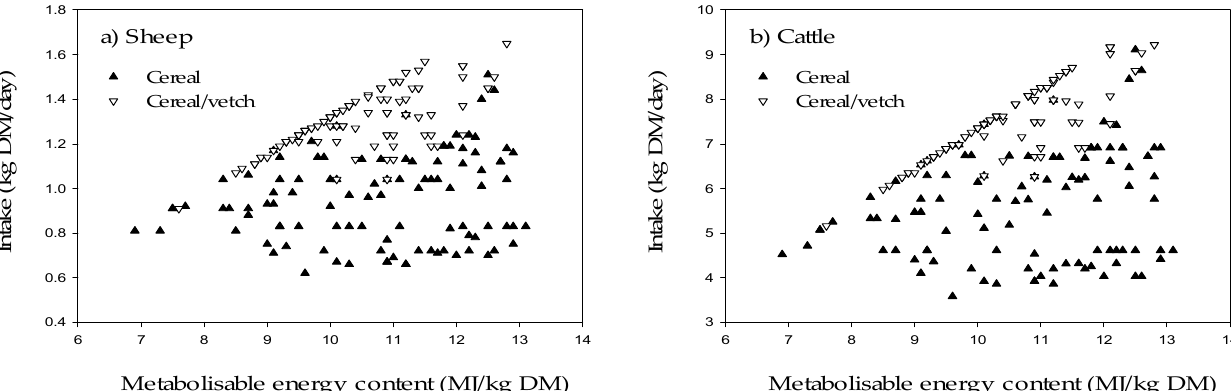
Figure 1. Relationship between estimated metabolisable energy content (MJ/kg DM) and predicted dry matter intake (kg DM/day) for ( a ) sheep and ( b ) cattle fed cereal and cereal/vetch crops grown at four sites across southern NSW in consecutive years: Wagga Wagga in 2008, Culcairn in 2009, Temora in 2010, and Coolamon in 2011.